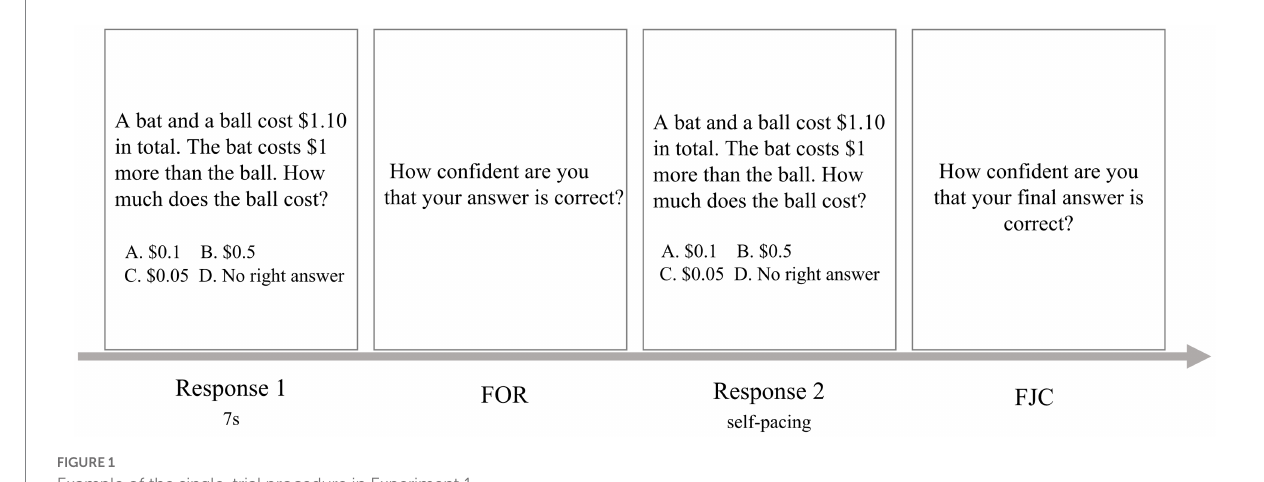
TABLE 1 Descriptive statistics ( M ± SD ) in Experiment 1.